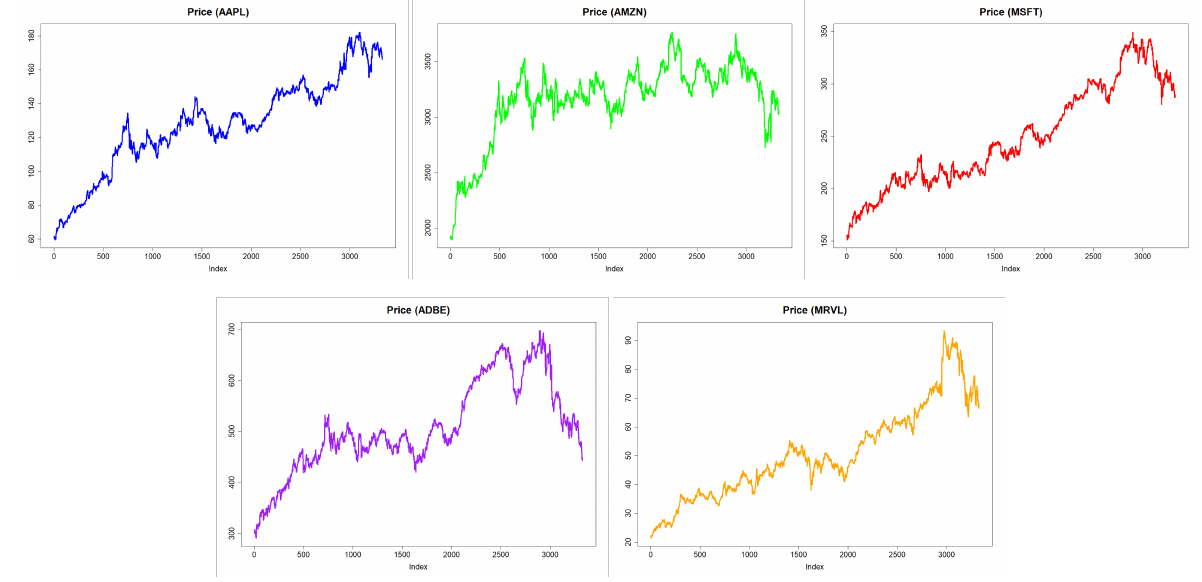
Figure 1. Hourly adjusted closing prices of stocks.